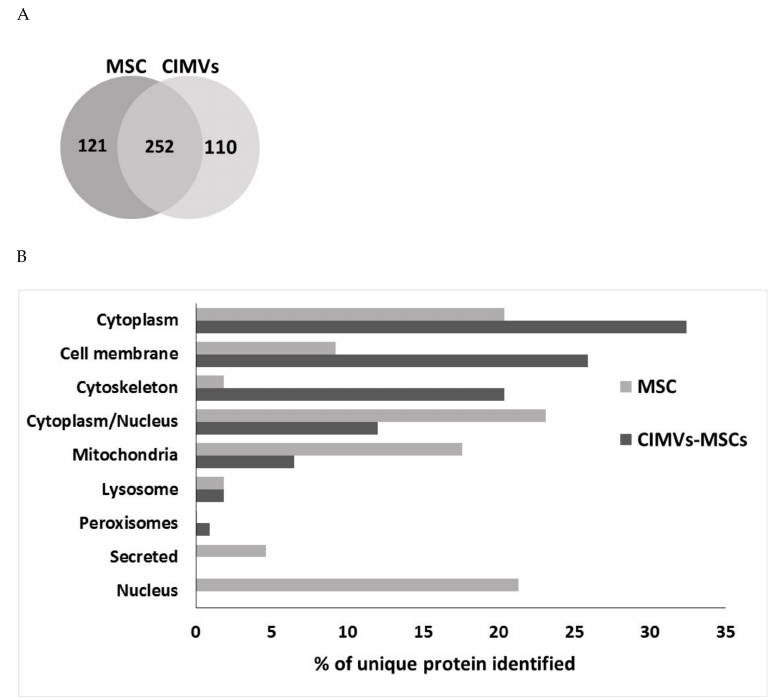
Figure 3. Proteome analysis of human MSCs and CIMVs-MSCs. Venn diagram of identified proteins MSCs and CIMVs-MSCs ( A ). Distribution of the identified proteins in organelles, % of unique identified proteins ( B